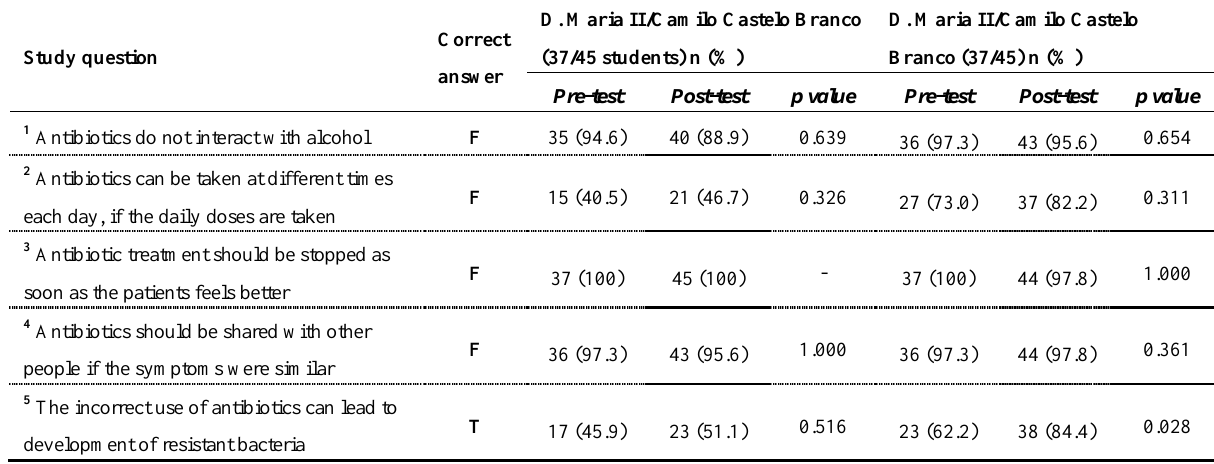
Table 4. Number of correct answers to questions on antibiotic treatment for bacterial